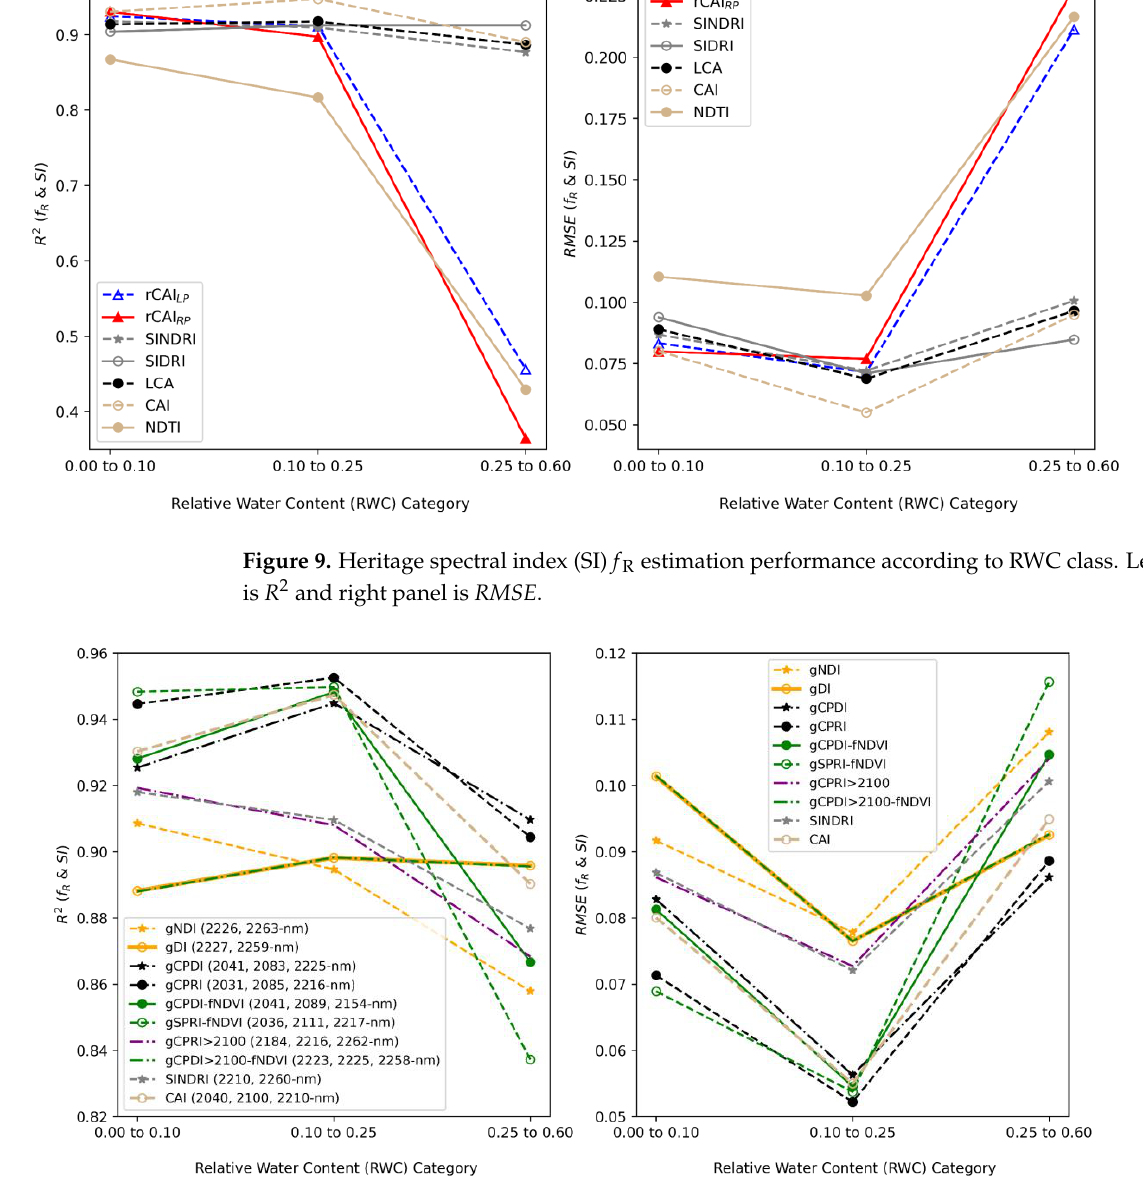
Figure 10. Wavelength shift spectral index (SI) f R estimation performance according to RWC class (with heritage SINDRI and CAI for performance comparison). Left panel is R 2 and right panel is RMSE . Note that “-fNDVI” denotes wavelength shift index derived from the 1 nm interval full-NDVI dataset, other wavelength shift indices are derived from the NDVI < 0.3 dataset. In the green vegetation analysis, nearly all indices exhibited a decrease in both R 2 and RMSE above 0.3 f GV . For reference, an f GV level of 0.3 has been found to correspond to an NDVI value of approximately 0.473 while an f GV level of 0.6 corresponds to an NDVI of 0.683 for green cover crops [45]. The decrease in both R 2 and RMSE is likely attributed to variance in index values diminishing for a given f GV category while also becoming less